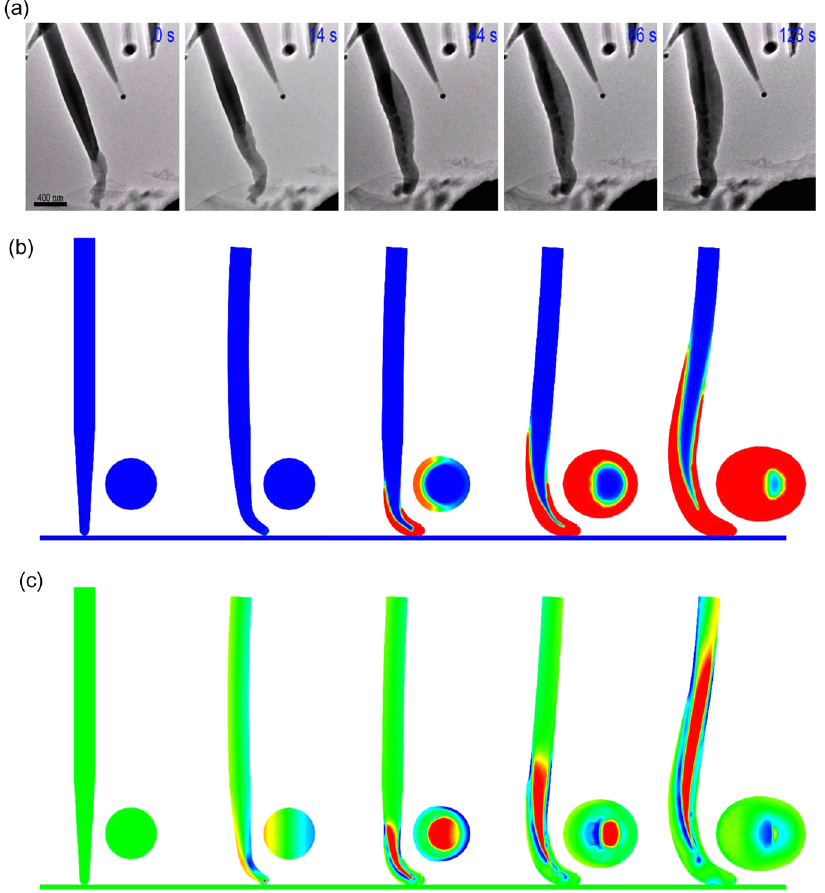
Fig. 5 External bending force breaks the lithiation symmetry in c -GeNWs. 93 a Time-elapsed TEM images show symmetry breaking of lithiation in a c -GeNW with applied bending force. A comparison of the lithiated thickness showed that lithiation proceeded appreciably faster along the tensile side than the compressive side. Li metal at the bottom of the image serves as the counter electrode and Li source. b Chemomechanical modeling of the symmetry breaking in a bent c -GeNW. The symmetry breaking occurs both in the longitudinal and radial directions of the nanowire. Blue : unlithiated region, red : lithiated region, transition color: ACI. Bottom blue substrate represents Li metal. c Mechanical stress evolution during the lithiation, corresponding to the lithiation kinetics shown in b . Red : tension, blue : compression The Li ion migration continues until the chemical potential same color) and thus they are isopotential. Bending the thin fi lm difference vanishes (III), establishing a new equilibrium state on device generates net tension in the bottom electrode and the two electrodes with different Li concentration (see the color compression in the top (II). The stress difference creates a difference in the two electrodes, eucalyptus and cyan , representing chemical potential difference, driving Li ions migration from the different Li concentrations). This new equilibrium state is set by compressed to the tensed electrode through the electrolyte (II-III).